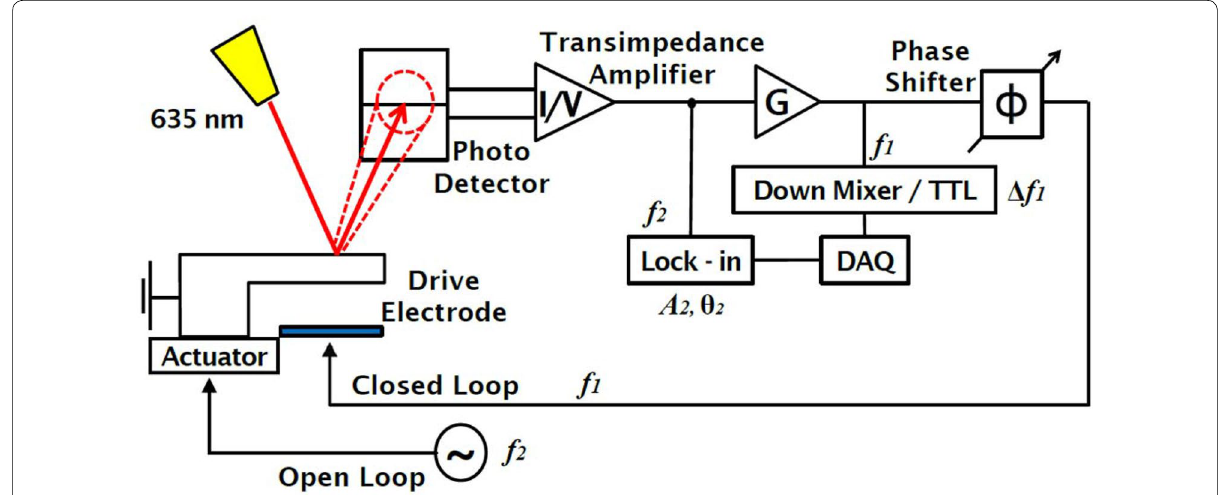
Fig. 3 Schematic of experimental setup. This setup is capable of measuring the frequency shift of the first resonance mode and amplitude change and phase shift of the second resonance mode simultaneously upon transit of a single microparticle through a microchannel